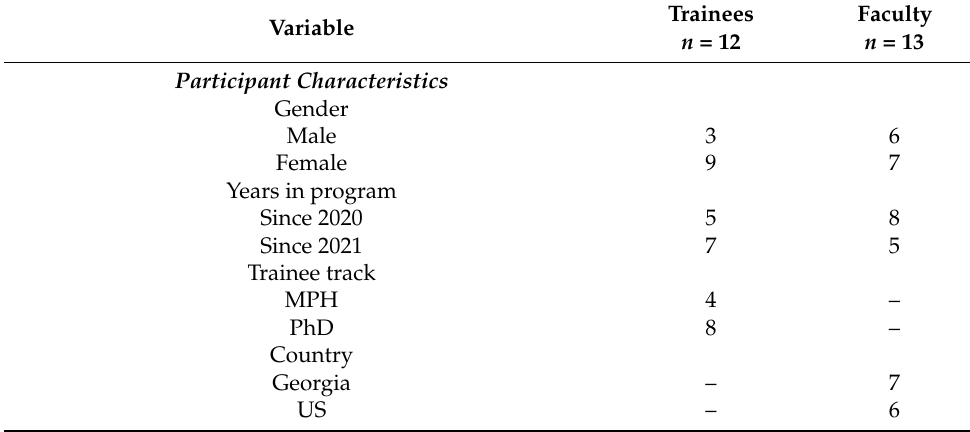
Table 1. CARE Training Program participant characteristics and mentor/mentee